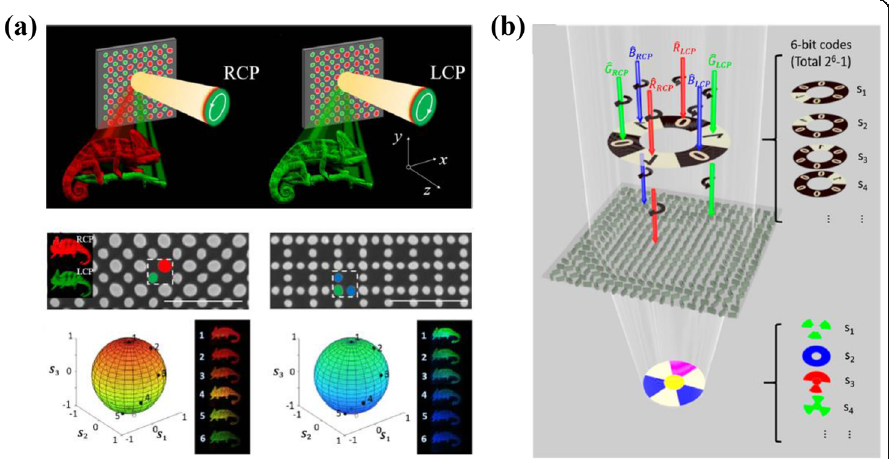
Fig. 2 Color holography based on metasurfaces. a Illustration of the polarization-controlled color hologram. The color of the reconstructed images can be tuned by changing the polarization of incident light [67]. b Schematic illustrations of the transmitted 6-bit metasurface consists of silicon nanobricks arrays with spatially varying orientations on a quartz substrate